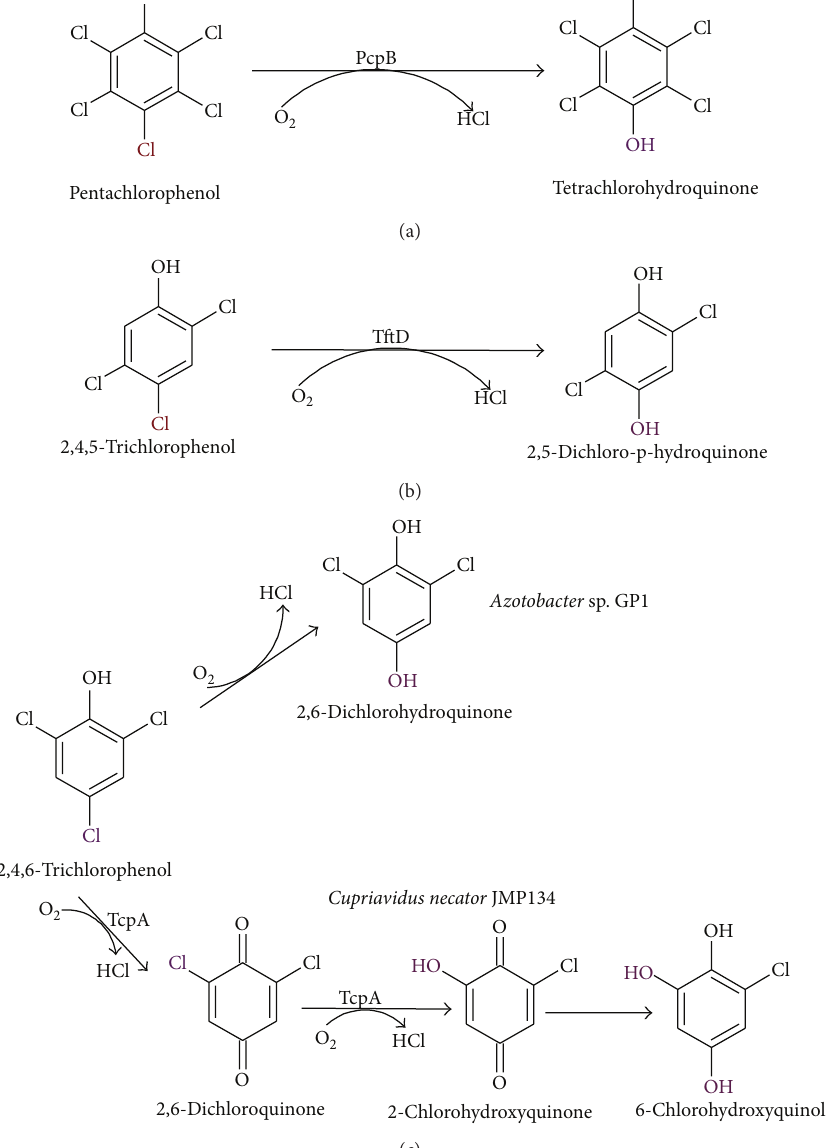
enzyme (TcpA) has been identified and characterized in Cupriavidus necator JMP134 [58,